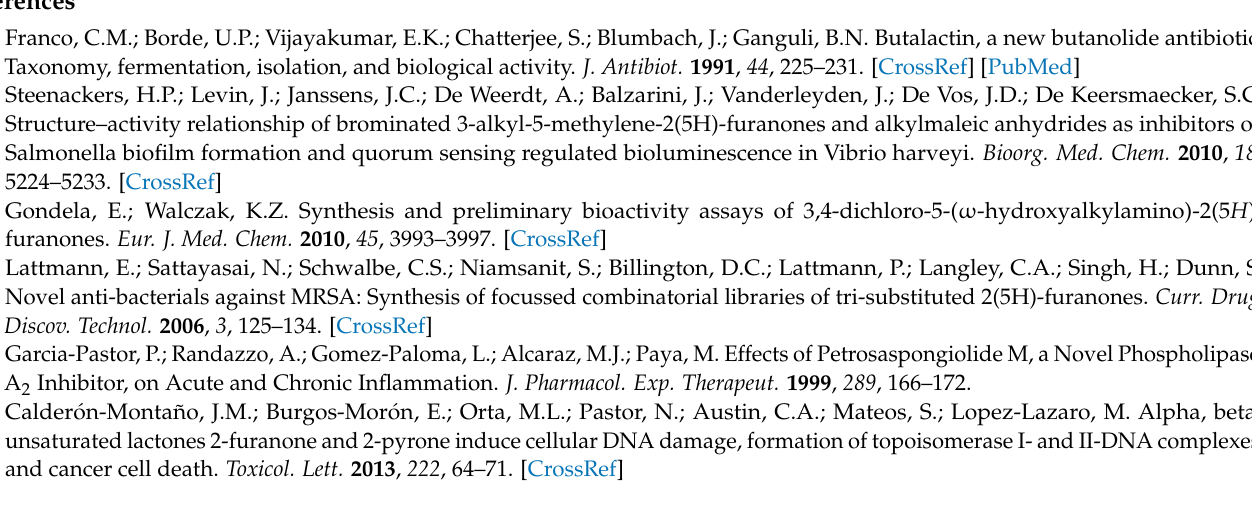
pounds: Figure S1: Results of viability of HCT116 and MCF-7 cells after 72 h of incubation with compounds at a dose of 0–100 µ